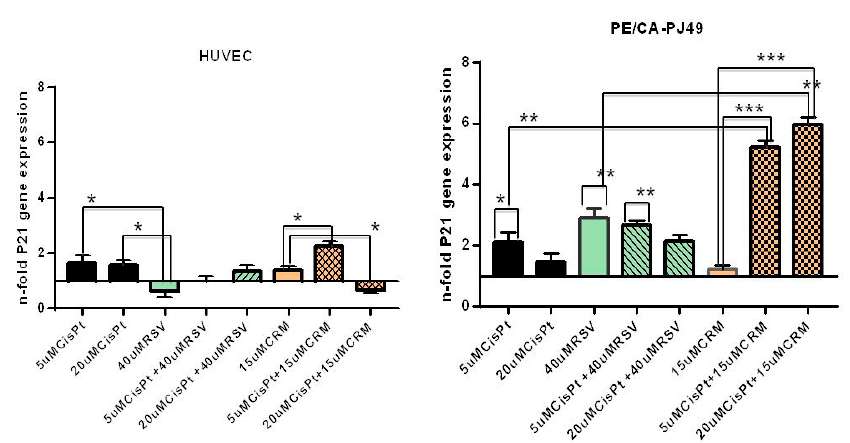
Figure 4. The effect of treatment with CisPt, RSV, CRM applied independently or in combination on P21 gene expression in tumor cells PE / CA-PJ49 compared to normal cells HUVEC. Each sample was performed in duplicate. The samples were analyzed using the formula 2- ∆∆ Ct = gene expression. (* p < 0.05, ** p < 0.005; *** p < 0.0005). Table 5. n-fold P21gene expression in PE / CA-PJ49 tumor cells versus normal cells HUVEC treated 24 h with CisPt and / or RSV, CisPt and / or CRM. The results were obtained using gene reference HPRT. Treatment HUVEC PE / CA-PJ49 Control 1 1 5 μ M CisPt 1.64